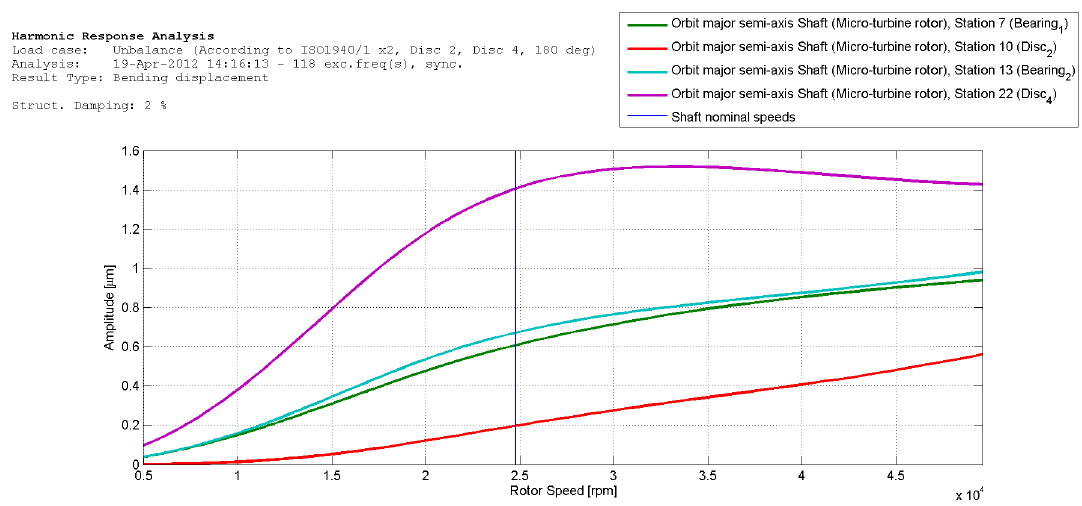
Figure 15: Amplitude of the rotor vibration for the unbalance of the discs No. 2 and No. 4 equal to 2.4 × 10 −6 kg · m, with angular travel 180°.